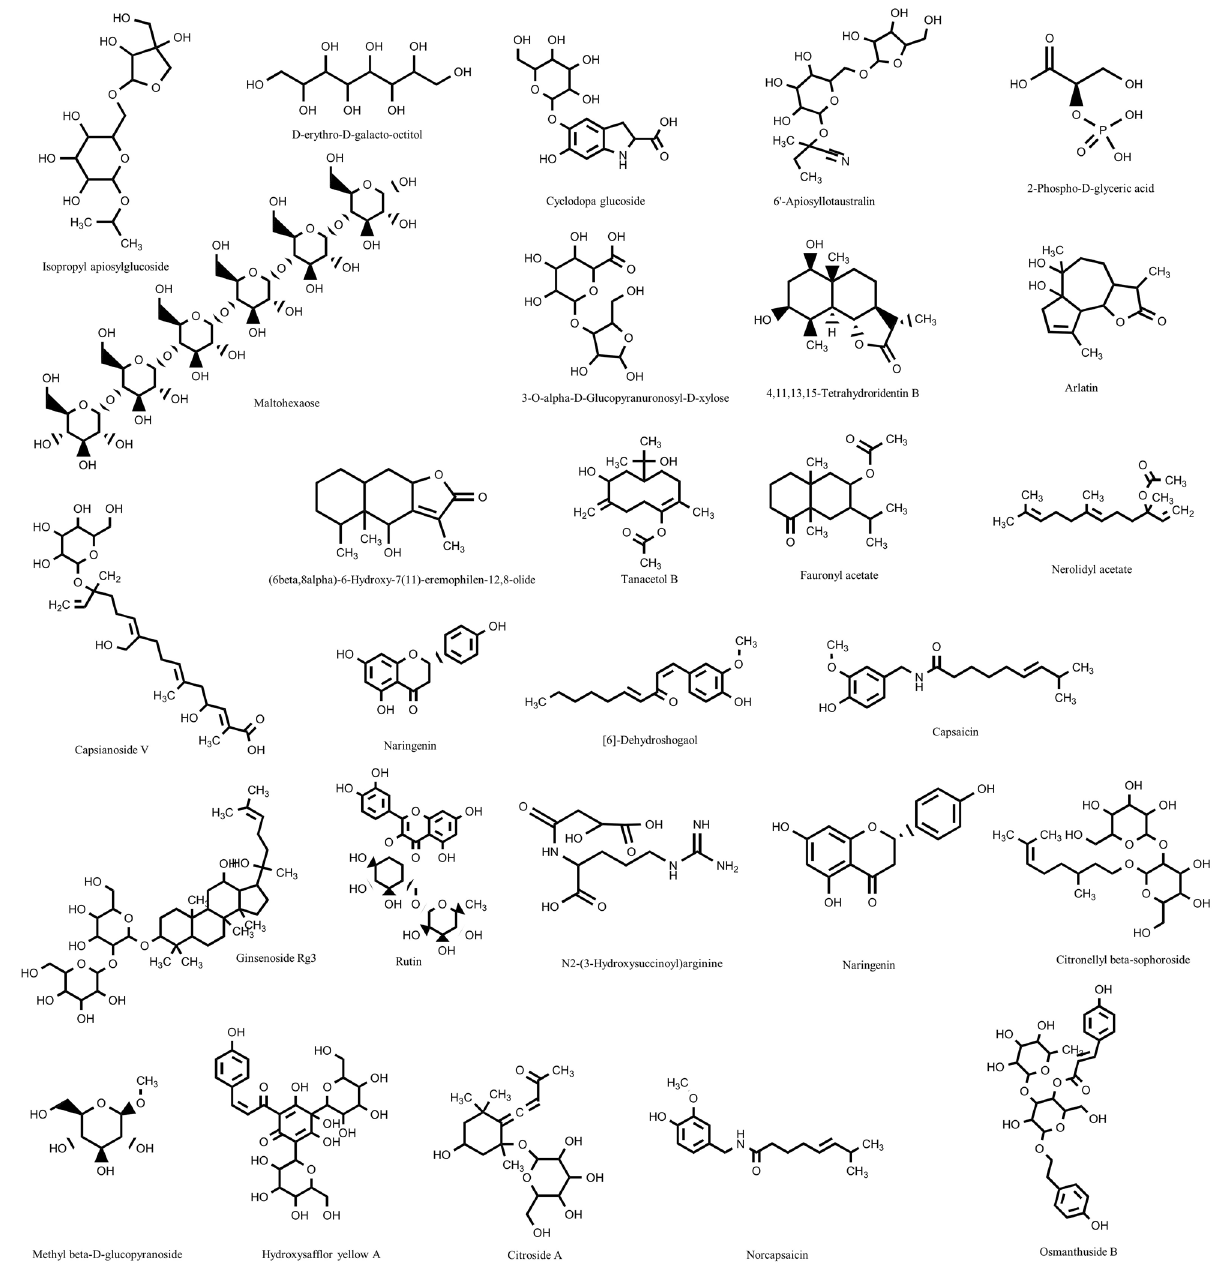
Figure 4. Chemical structures of typical compounds from